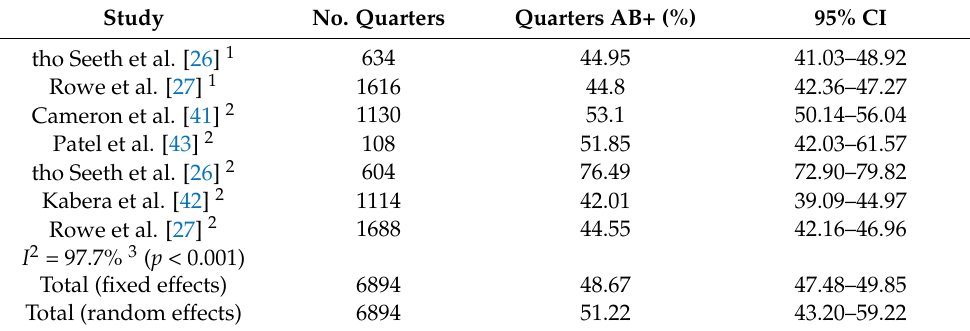
Table 4. Proportion of antibiotic use at drying-off (AB+) within the selective dry cow treatment groups including 6894 quarters.